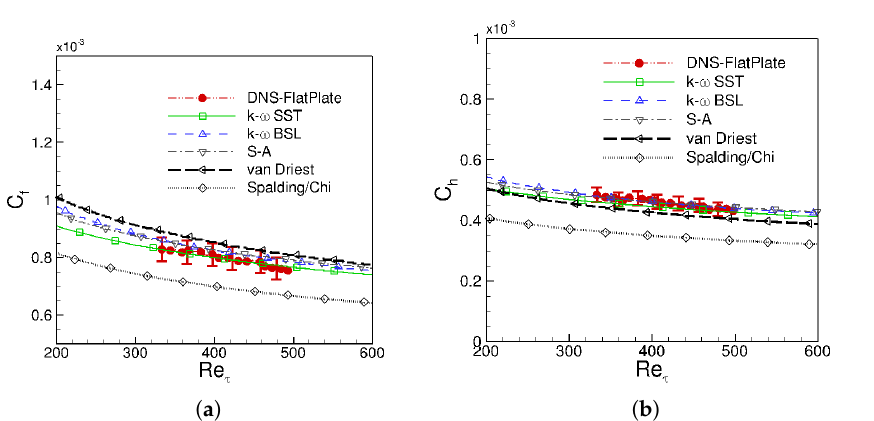
Figure 4. Comparison of ( a ) skin friction coefficient C f and ( b ) wall heat transfer coefficient C h among DNS, RANS, and empirical correlations. Error bars represent 5% of the DNS value.